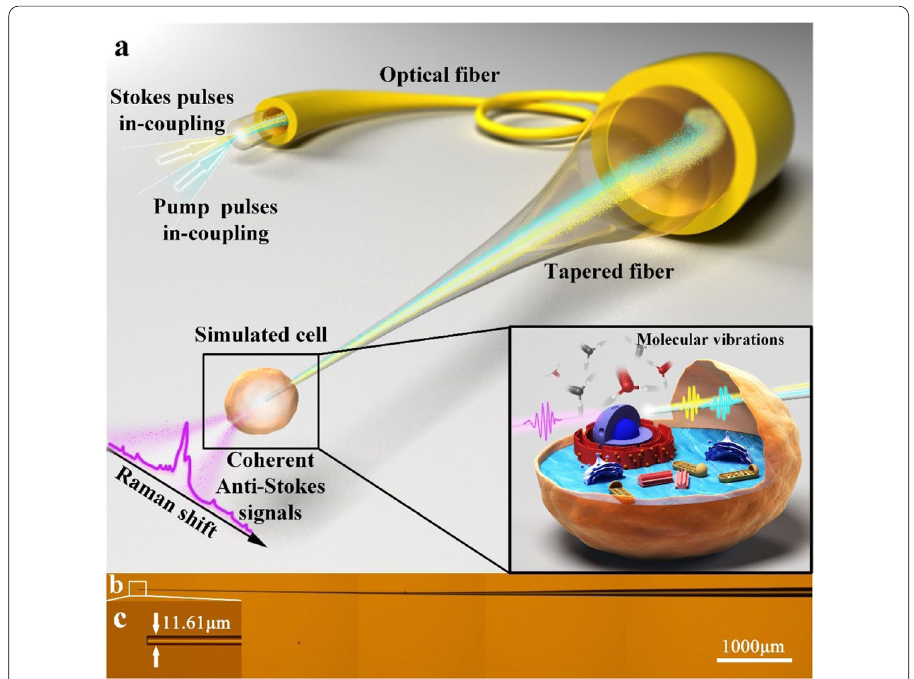
Fig.1 Principle of a CARS tapered optical fiber probes for single-cell minimally invasive endoscopy. a Illustration and (b) photography of fabricated device including a tapered fiber tip. c Enlarged view of the fiber